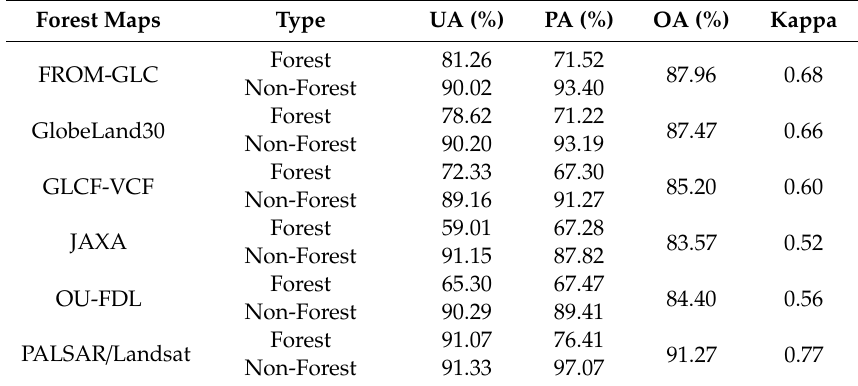
Table 3. Accuracy comparison between PL-based forest map and existing five forest maps with 30–50 m resolutions.